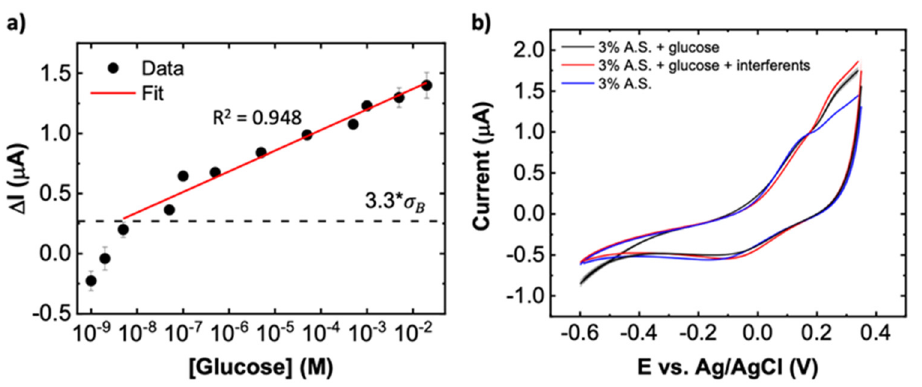
Figure 5. Sensor sensitivity, selectivity, and response in artificial saliva. ( a ) Baseline-subtracted values of oxidation current at 0.21 V for various glucose concentrations in 0.1 M Na 2 SO 4 (pH 6.4). The error bars depict the standard errors with n = 6–9. σ B represents the standard deviation of the blank solutions. ( b ) Average CV response in 3% diluted artificial saliva (A.S.) with either no glucose or spiked with 65 µ M glucose or 65 µ M glucose with interferents consisting of a mixture of UA (175 µ M) and AA (600 nM) spiked into artificial saliva before dilution of solutions. The curves are obtained from an average of 5 CV scans and the shaded regions surrounding the curve represents the standard error of the 5 CV scans. Scan rate = 50 mV s − 1